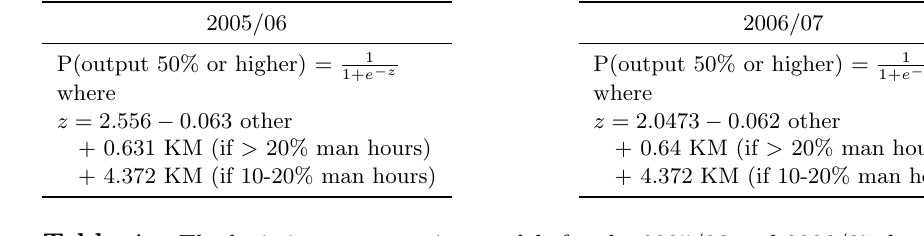
Table 4: The logistic representation models for the 2005/06 and 2006/07 data sets.